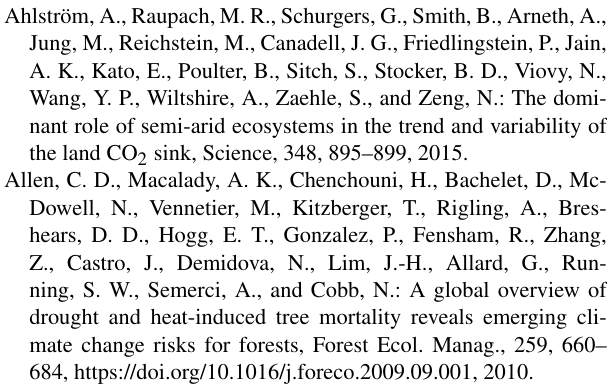
15.5 no limit − 32 − 2 550 30 BoNS (boreal needleleaf summergreen) no limit − 2 350